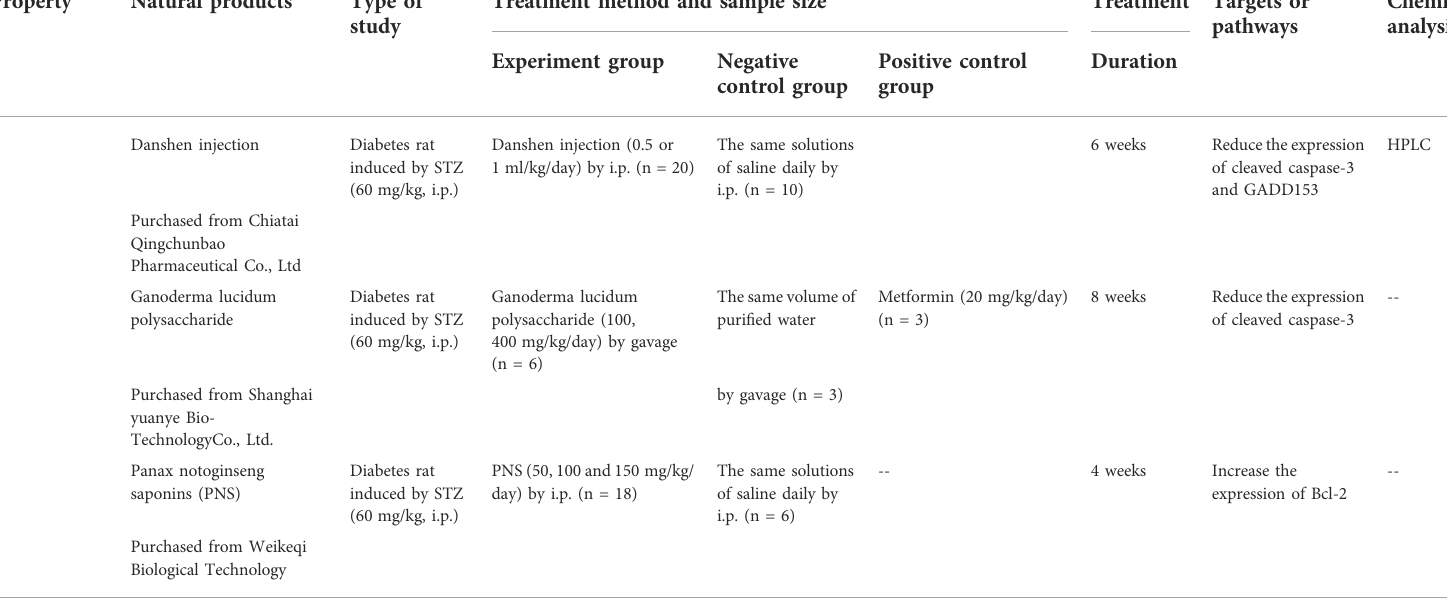
TABLE 2 ( Continued ) The mechanisms by which Traditional Chinese medicine treat